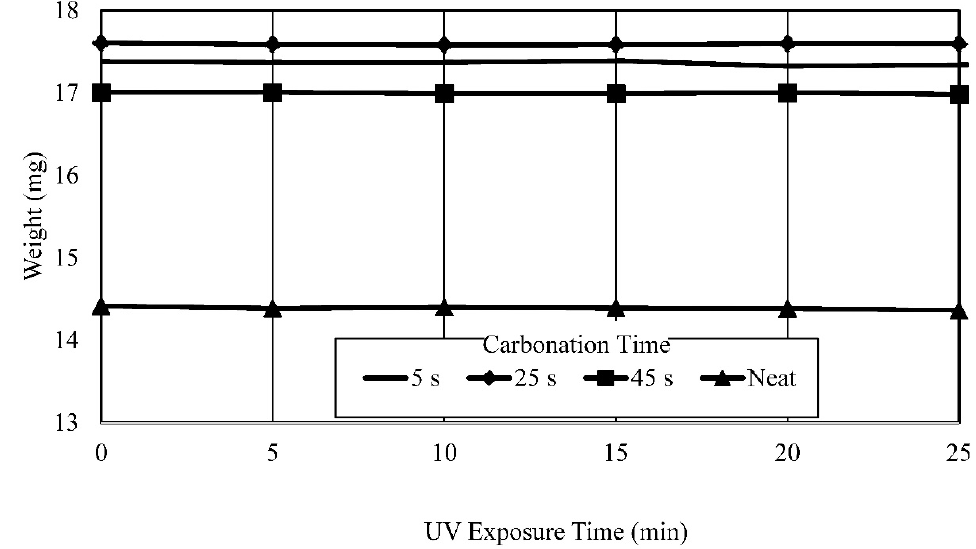
Figure 5. Effect of carbonation duration and post-UV exposure time on polymer weight.